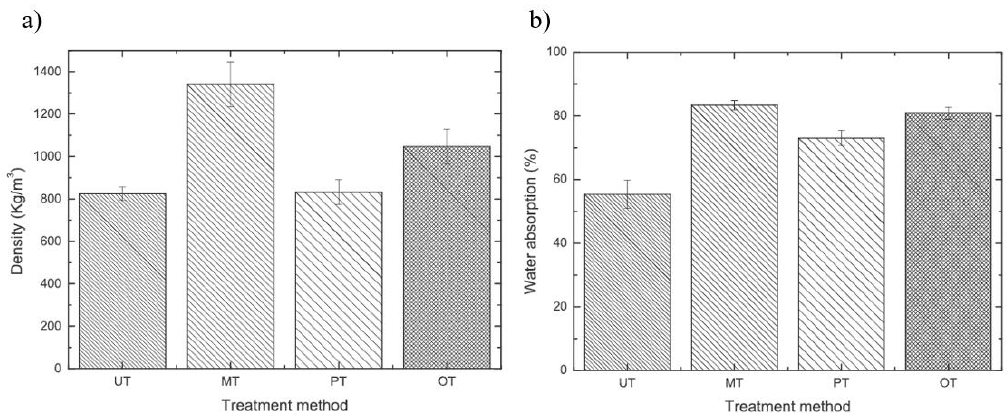
Figure 8. Effect of treatment on: ( a ) the density of bamboo fibre and ( b ) water adsorption of bamboo fibre [34].